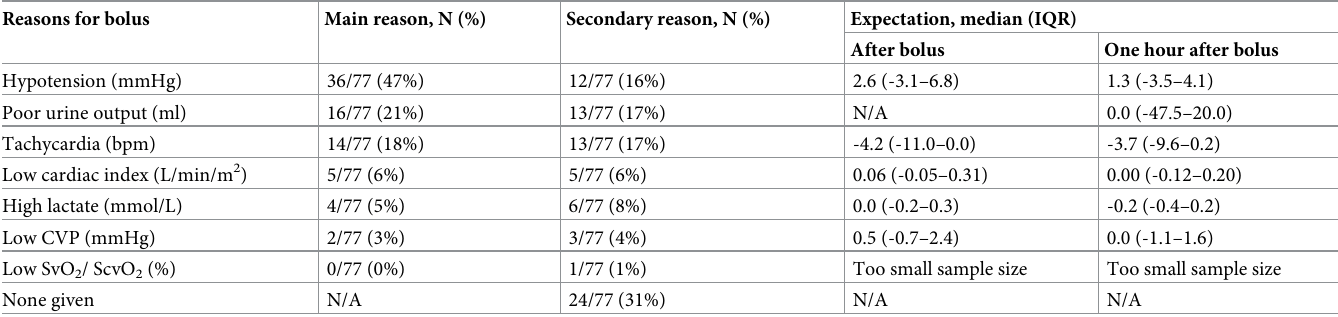
Table 3. Triggers for FBT and physiological